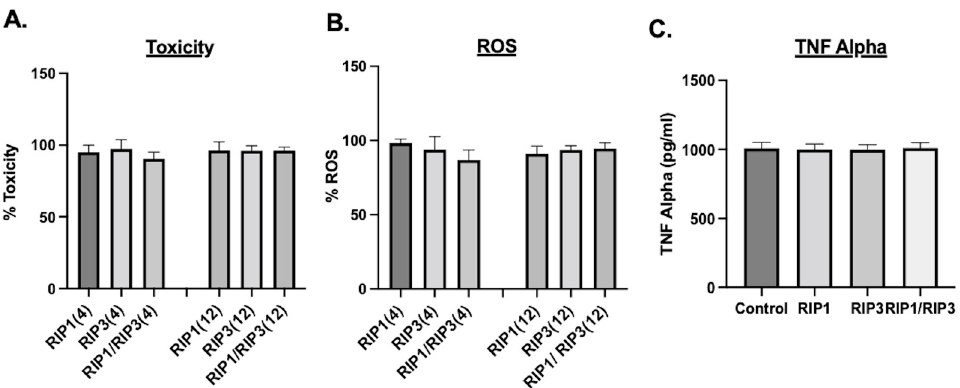
Figure 6. ( A , B ) Effect of aggregates on normal cell toxicity and ROS. Normal lung BEAS-2B cells were plated in 96 wells at a density of 10,000 cells/well. RIP1/RIP3 aggregates were added at a concentration of 10 µ M and incubated for 48 h, and Alamar blue/ROS measurements were performed. ( C ) TNF alpha assay. Raw264.7 cells were plated at a density of 10,000 cells/well in 96 well plates. RIP1/RIP3 aggregates were added at a concentration of 100 µ M and incubated for 48 h. TNF-alpha assay was performed according to the manufacturers protocol, and measurements were obtained using a M3 plate reader.